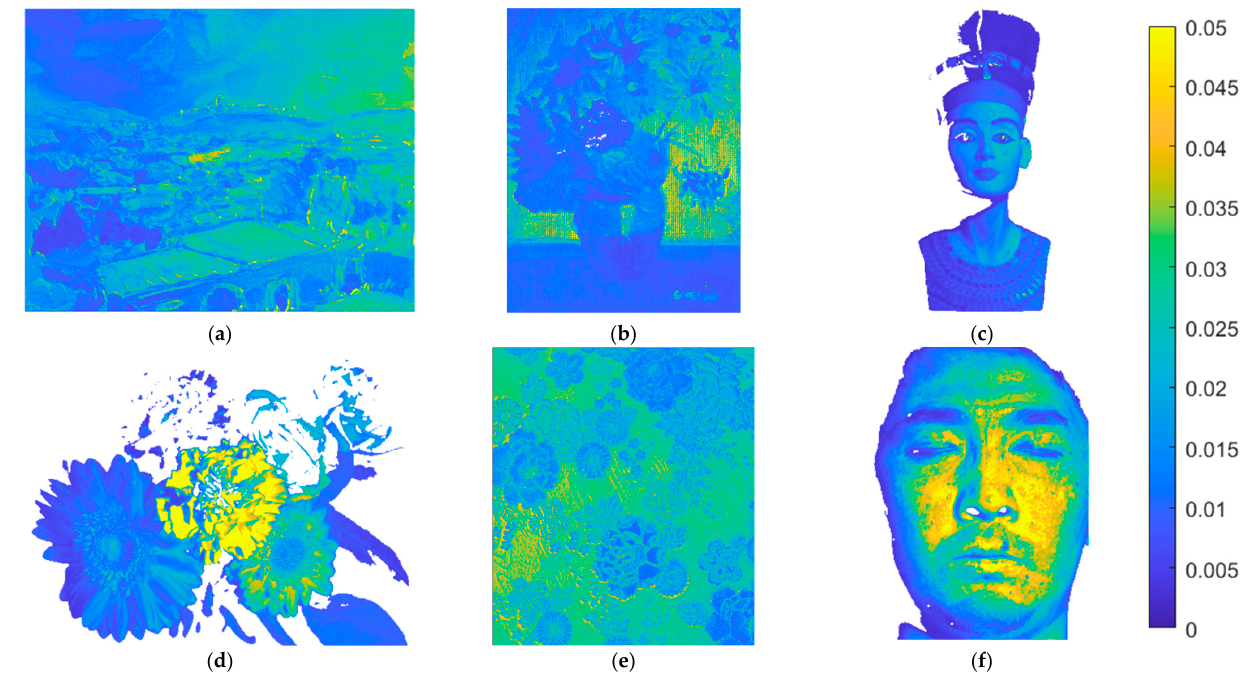
Figure 16. ( a – f ) showing the E Ref maps for the test images in Figure 15a–f, respectively, using the II-LUT method and RGBF camera. Pixel E Ref values greater than 0.05 are set to 0.05.